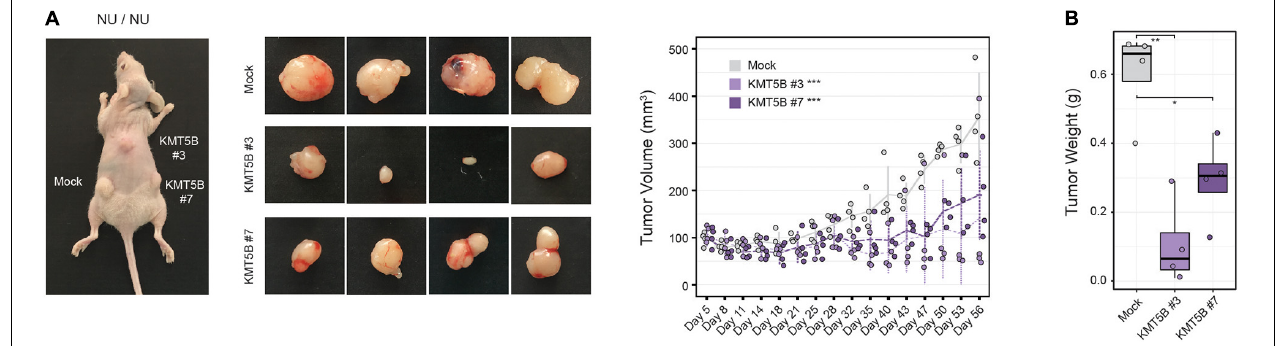
FIGURE 5 | In vivo effect of KMT5B overexpression. (A) Mock or KMT5B -transfected LN-229 cells were subcutaneously injected into the flanks or the neck base of 4 nude mice. An image of the tumors excised after animal sacrifice is shown on the left. Tumor growth was monitored for 56 days [General linear model (GLM) *** p -value < 0.001]. (B) Box plot represents average tumor weights for the tumors generated by each clone (Wilcoxon rank sum tests; * p < 0.05; ** p <